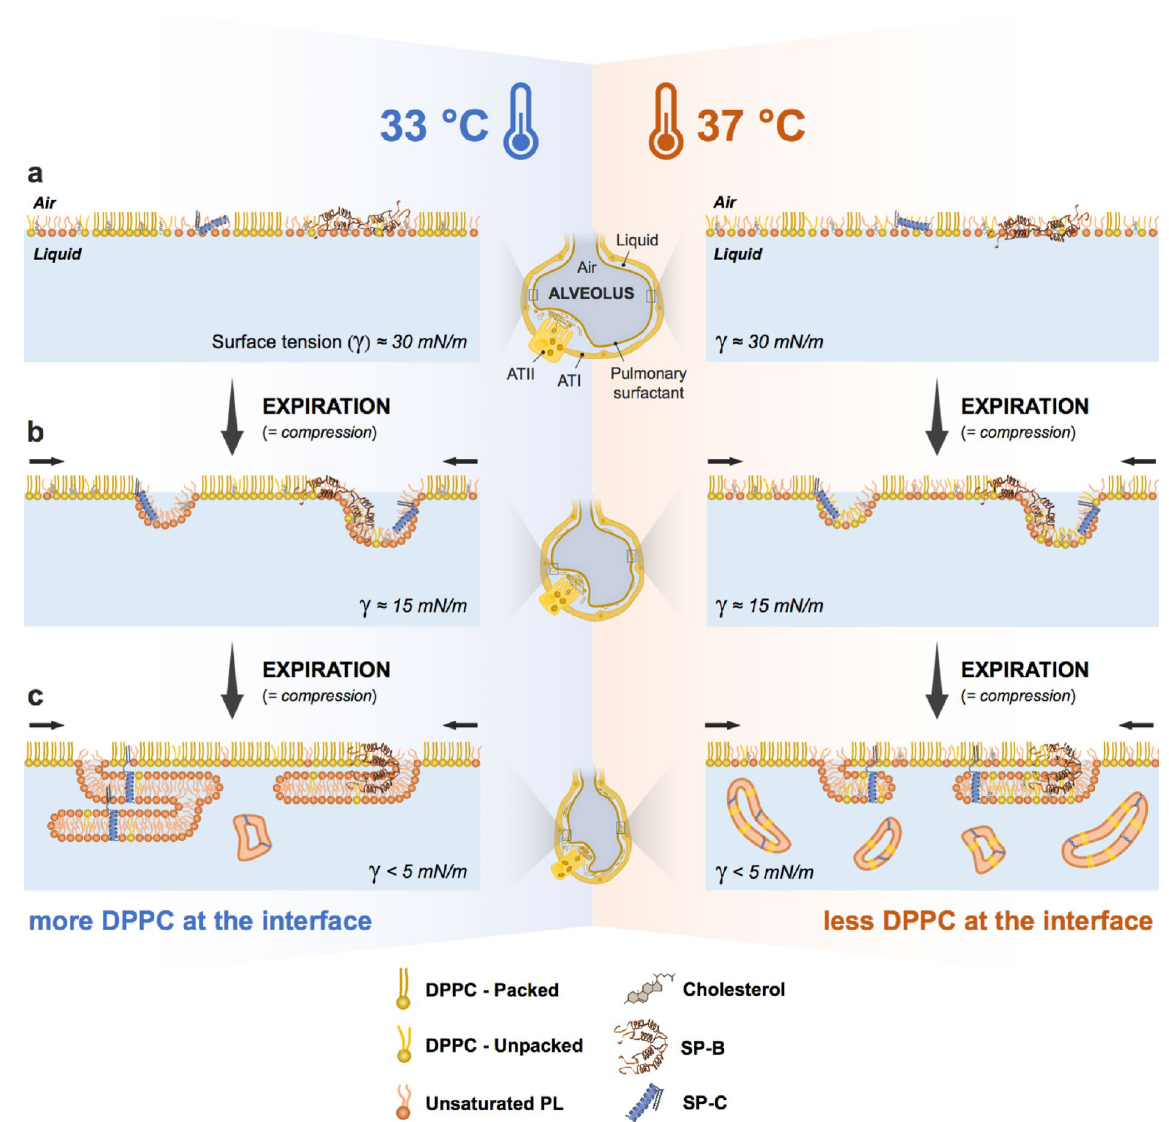
Figure 7. Temperature-mediated compression-driven reorganization of surfactant at the air–liquid interface. ( a ) When surfactant adsorbs at the air–liquid interface, the lateral segregation between packed ordered domains (DPPC enriched) and expanded disordered lipids is less evident at 37 °C due to temperature-facilitated mixing. Larger condensed domains are visible at 33 °C. (b ) During compression (at expiration), SP-B and SP-C promote surfactant reorganization at the air–liquid interface, facilitating maximal reduction in surface tension. Areas rich in lipids with lower stability at high pressures, and therefore poorer surface-active properties (unsaturated lipids) are laterally and three-dimensional excluded from the air–liquid interface. Due to lipid de-mixing, the condensed ordered/liquid-expanded disordered phase separation is more evident at 33 °C. This leads to compression-driven preferential exclusion of unsaturated lipids. Conversely, a fraction of DPPC is also lost from the interface at 37 °C because of the temperature-dependent partial mixing. ( c ) At high compression rates of the alveolar interface (at the end of expiration), lipids excluded from the interface are organized in three-dimensional structures that remain below. These structures might be more stable and firmly associated to the surface at 33 °C than 37 °C. Indeed, part of those membranes, containing higher DPPC proportions, may detach from the surface at 37 °C. This probably fuels both catabolism and recycling of surfactant lipids under physiological conditions when new surfactant components continuously adsorb and replenish the lost material at the interface. Conversely, the adsorption of surfactant would be compromised by several plasma compounds when they pass from systemic circulation to the alveolar space. This affects the amount of DPPC available to reduce surface tension at 37 °C and suggests a protective role at 33 °C. SP-B surfactant protein B, SP-C surfactant protein C, γ surface tension, AT-I alveolar type I cell, AT-II alveolar type II